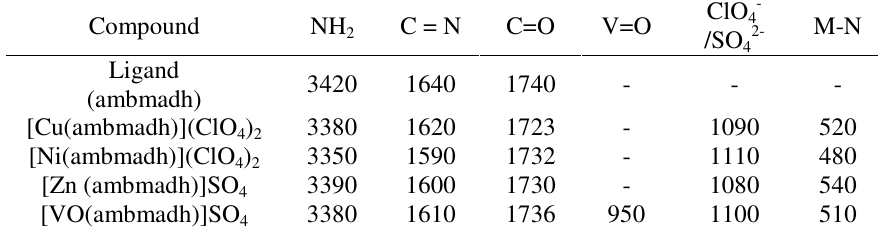
Table 2 . Characteristic IR bands (cm -1 ) of the compounds studied